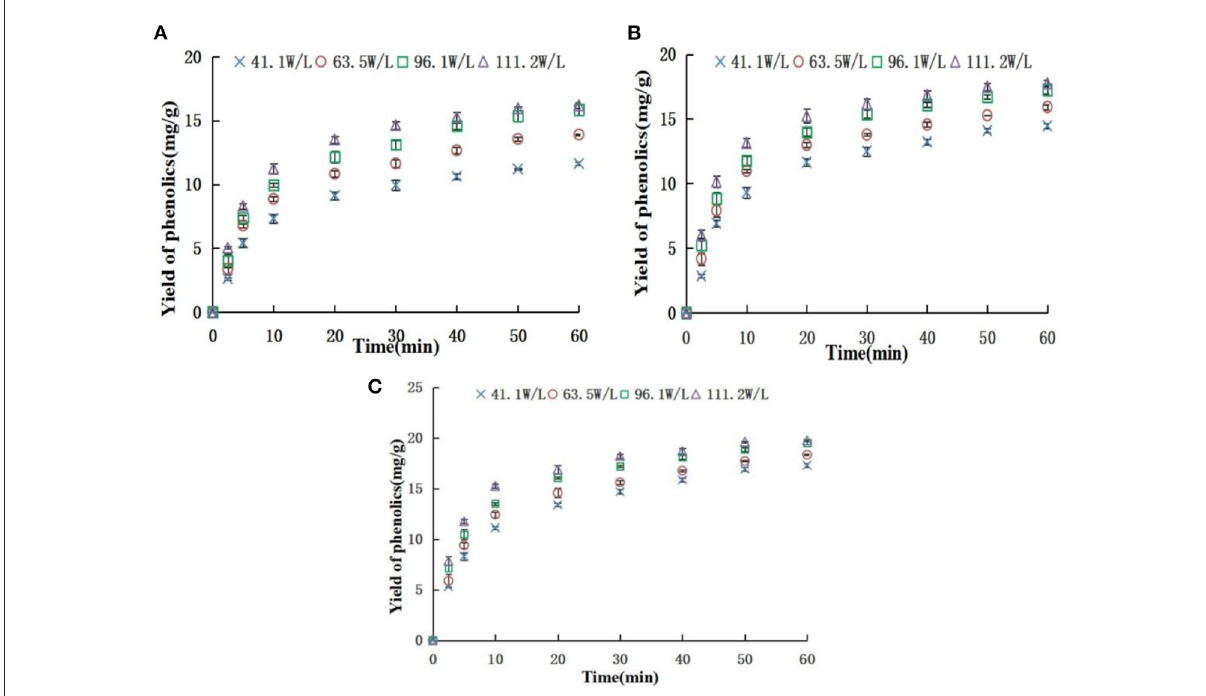
FIGURE4 Effect of acoustic energy density on yield of phenolics [ (A) 20 ◦ C; (B) 30 ◦ C; (C) 40 ◦